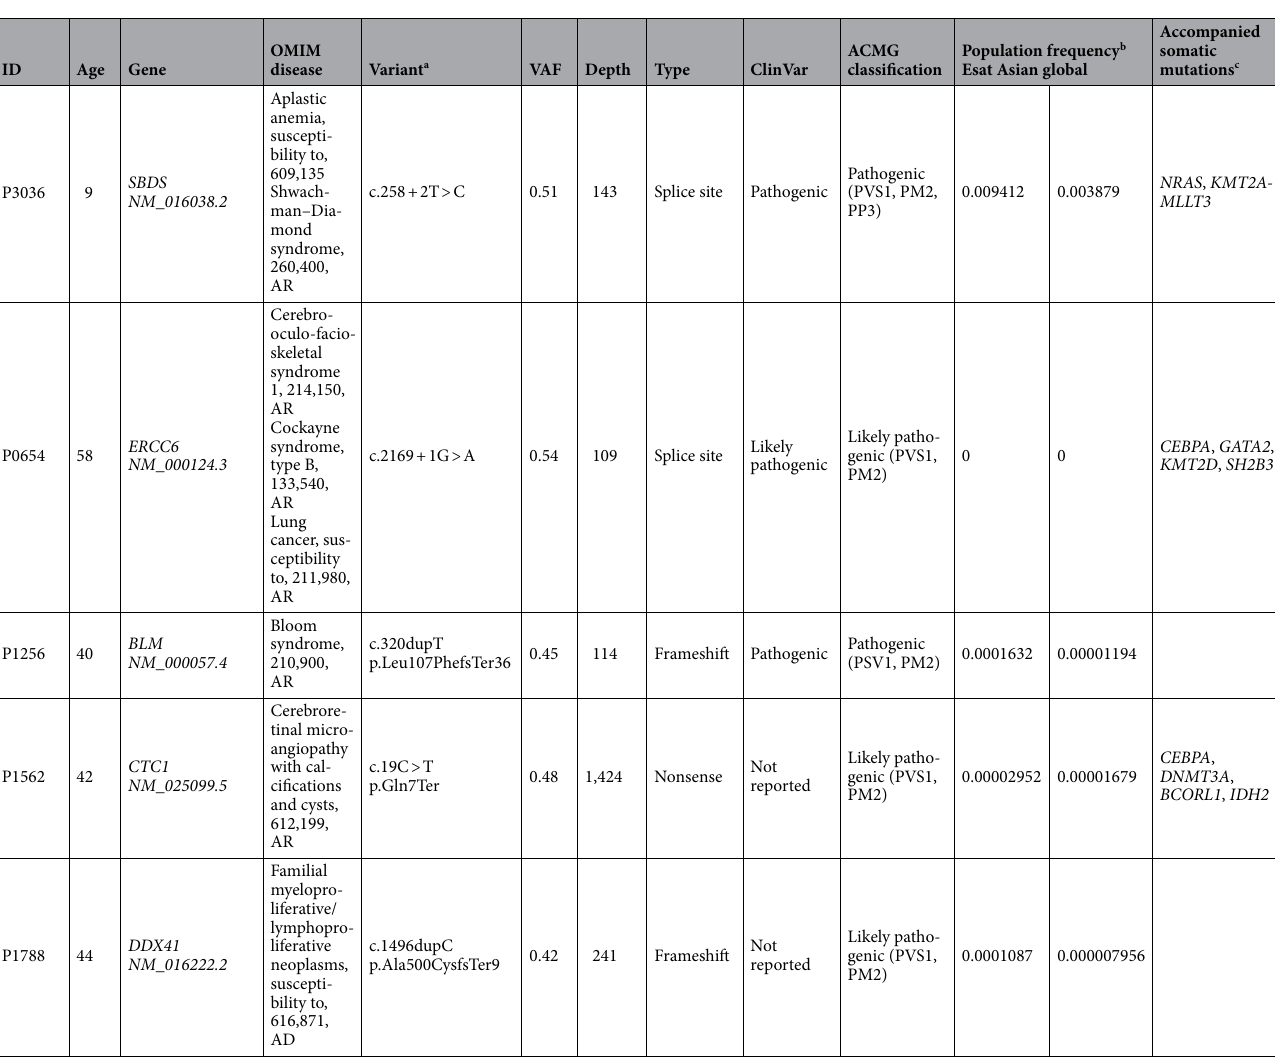
do not develop FA, monoallelic mutations in BRCA1 /2, or PALB2 are associated with increased risk of specific cancers, e.g., breast cancer. Recent National comprehensive cancer network (NCCN) guidelines suggest that car- riers of those mutations should be included in the surveillance program and should consider preventive actions (https ://www.nccn.org/profe ssion als/physi cian_gls/pdf/genet ics_scree ning.pdf). The same principle should hold for the patient with AML with germline predisposition mutations. Besides, BLM is associated with Bloom syndrome, a rare chromosomal instability disorder characterized by growth retardation, immunodeficiency, and a wide spectrum of cancers 12 . BLM mutation is known to be associated with cancers 13 . ERCC6 plays a critical role in DNA repair, and an association between disruption of its function and increased susceptibility to cancer has been reported 14 . CTC1 is known causative genes of the telomere biology disorder DC, characterized by accelerated telomere shortening leading to manifestations such as bone marrow failure, cancer, and pulmonary fibrosis 15 . DC genes function in telomere maintenance; CTC1 functions in a telomere-associated complex to protect the telomere from lethal DNA degradation 16 . Although these DC genes have autosomal recessive inheritance, an association between monoallelic deleterious germline mutations and myeloid malignancies has been reported 17 . Splice site mutations of the SBDS , a causative gene of SDS, were identified in two patients. This mutation also had relatively high frequency among the control population (0.0048 from KRGDB and 0.004 from gnomAD East Asians), probably reflecting high carrier frequency. SBDS is characterized by exocrine pancreatic insufficiency, skeletal abnormalities, and bone marrow failure with an increased risk of myeloid malignancy 18 . Approximately